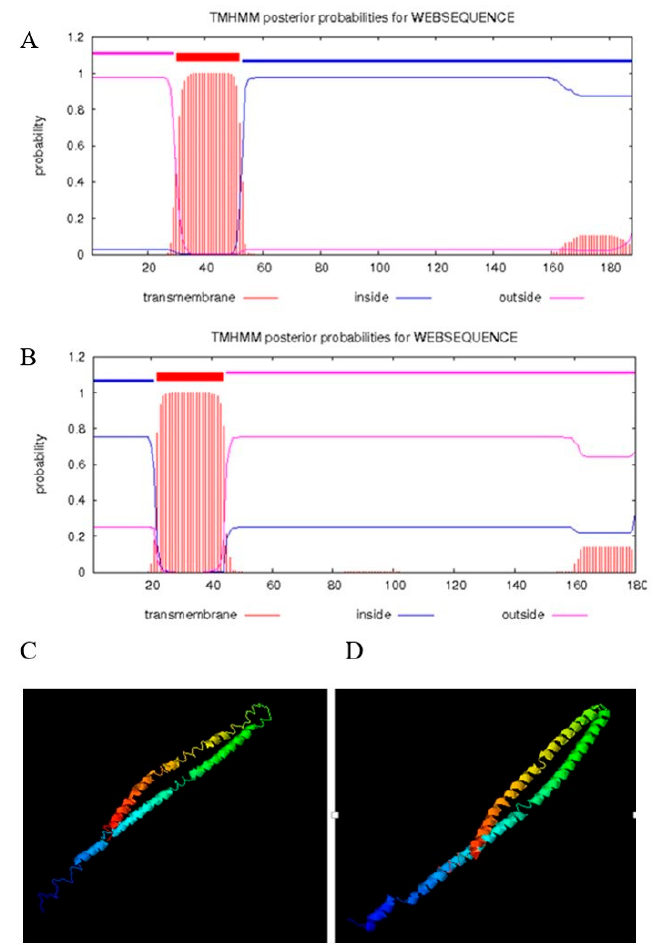
Figure 2. Prediction of the transmembrane structures and 3D structures of human tetherin and canine tetherin. ( A ) Transmembrane structure of canine tetherin; ( B ) transmembrane structure of human tetherin; ( C ) simulated 3D structure of canine tetherin; ( D ) simulated 3D structure of human tetherin. I-TASSER uses the SPICKER programme to analyse all the protein structures in the PDB database and